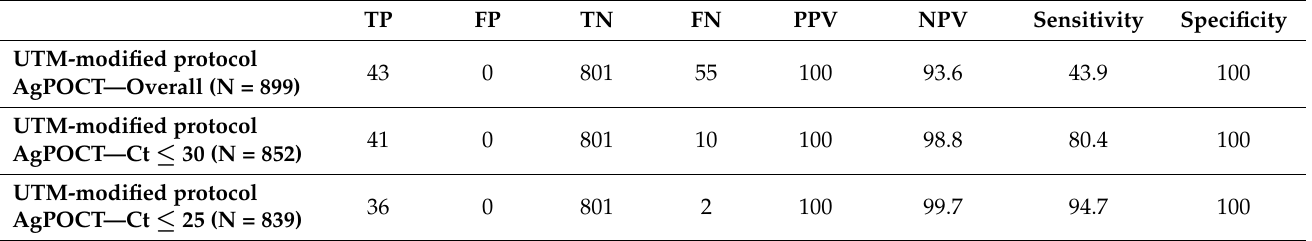
Table 2. Evaluation of the diagnostic accuracy of the UTM-modified protocol for rapid antigen testing in the emergency department. Data are expressed as %